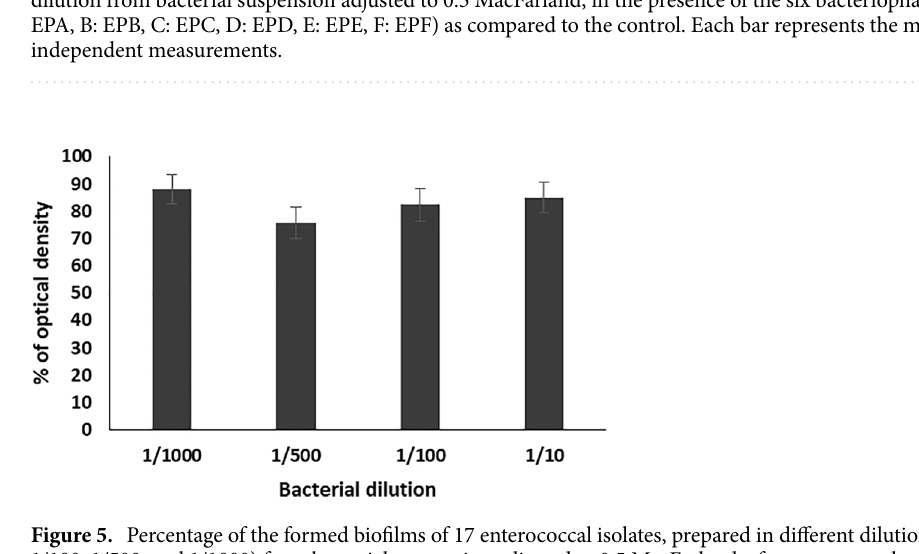
Figure 4. Percentage of optical density of the formed biofilms of 17 enterococcal isolates, prepared in 1/500 dilution from bacterial suspension adjusted to 0.5 MacFarland, in the presence of the six bacteriophages (A: